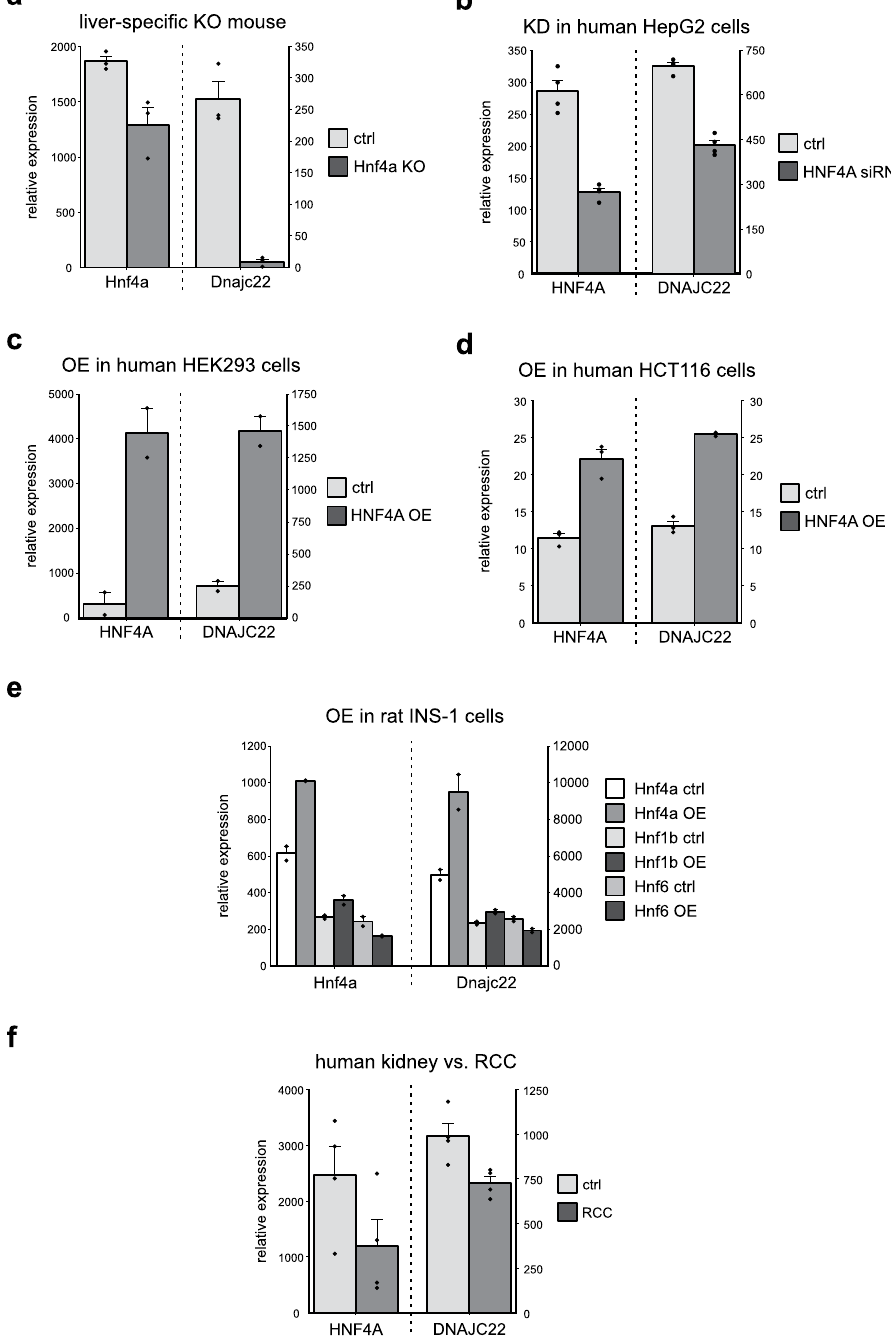
Figure 2. Alterations of cellular Hnf4a transcript levels affects Dnajc22 expression. Data for Hnf4a and Dnajc22 transcript levels in different Hnf4a-dependent experiments were extracted and reanalysed from online available GEO datasets. The significance of the observed differences was assessed using a one-sided t-test. ( a ) Hepatic tissue from liver-specific Hnf4a knockout and control mice (n = 3). ( b ) Knockdown of HNF4A by siRNA in human embryonic kidney cells (n = 4). ( c ) Doxycyclin-induced overexpression of HNF4A in human embryonic kidney cells (n = 2). ( d ) Doxycyclin-induced overexpression of HNF4A in human colon carcinoma (HCT116) cells (n = 3). ( e ) Doxycyclin-induced heterologous expression of HNF4A, HNF6, and HNF1B in rat insulinoma (INS-1) cells (n = 2). ( f ) Comparison of human healthy and renal carcinoma (RCC) tissue samples (n =